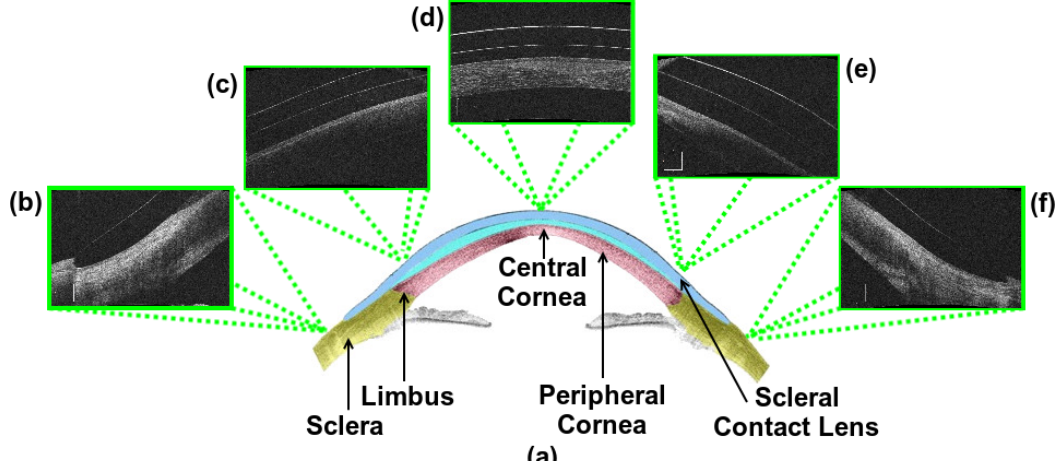
Figure 1. Schematic representation of anterior segment optical coherence tomography (AS-OCT) images. ( a ) An illustrative example of the anterior pole segment, including sclera, limbus, central cornea, peripheral cornea and scleral contact lens. ( b , f ) Extreme regions of the SCL where the outer layer is the one that meets the sclera. ( c , e ) Peripheral cornea and limbus region where the inner layers of the SCL progressively approach and finally join to the sclera. ( d ) Central cornea where the SCL always maintains a distance to the